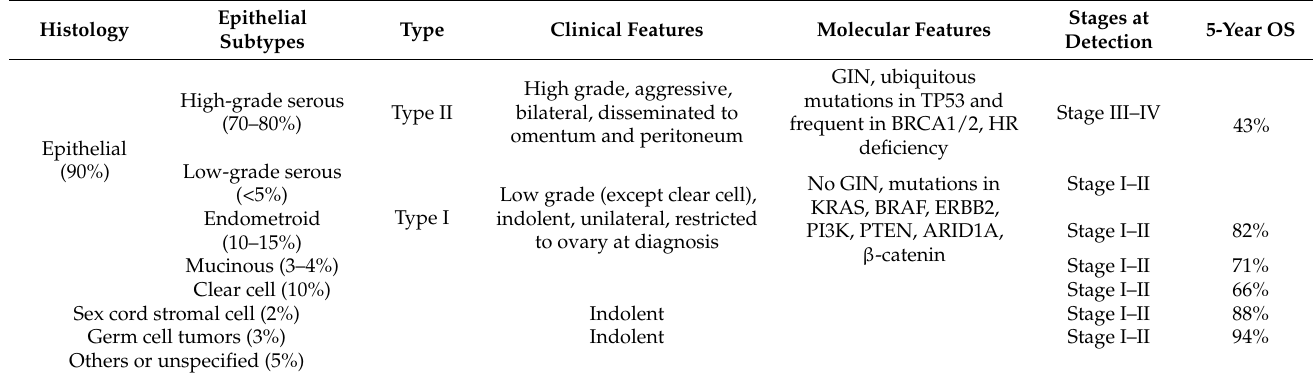
Table 1. Histological, clinical, and molecular features of ovarian cancer subtypes. OS, overall survival; GIN, genetic instability; HR, homologous recombination.